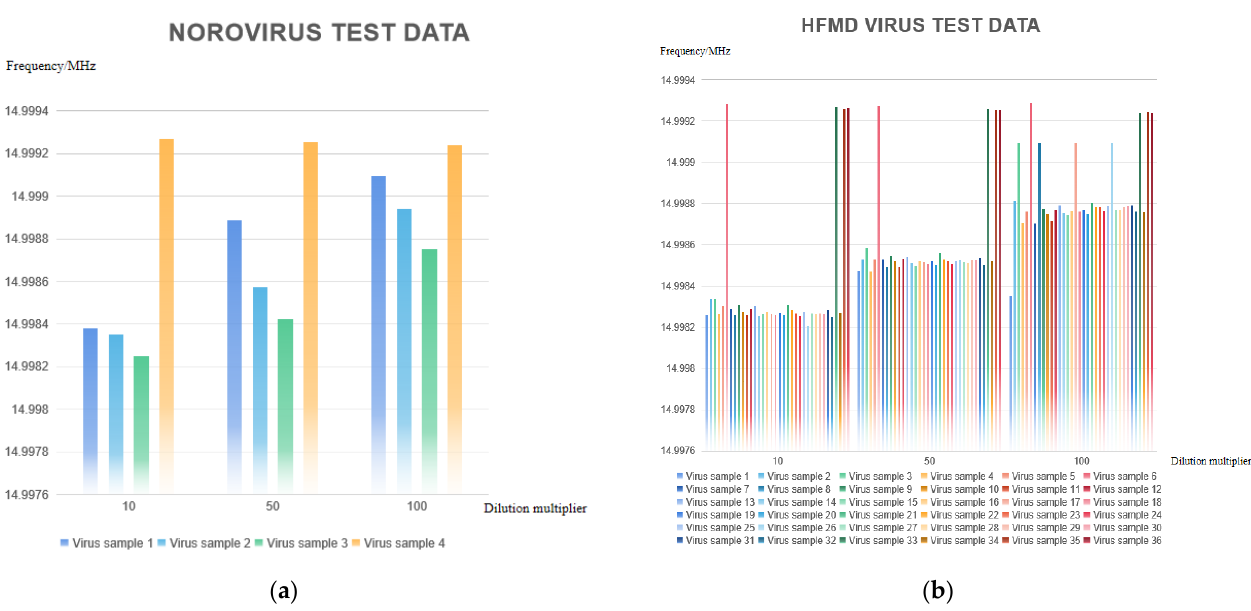
Figure 8. ( a ) Norovirus test results at different dilution concentrations; ( b ) HFMD test results at different dilution concentrations.